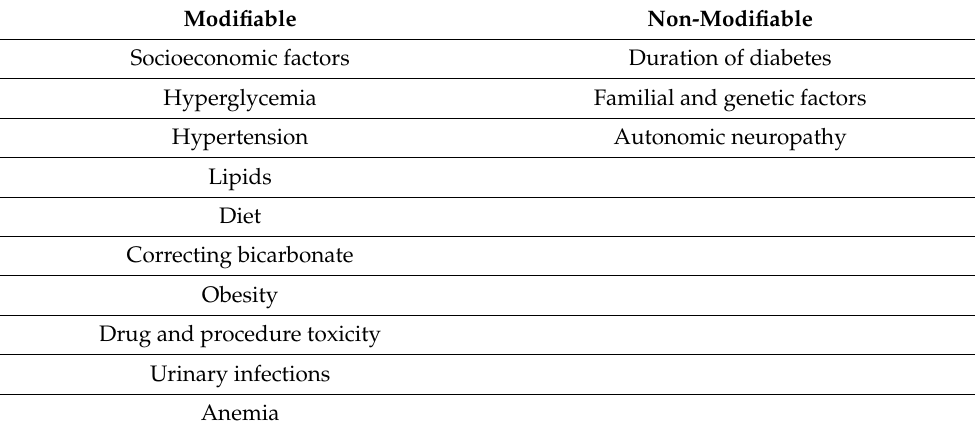
Table 1. CKD progression risk factors in